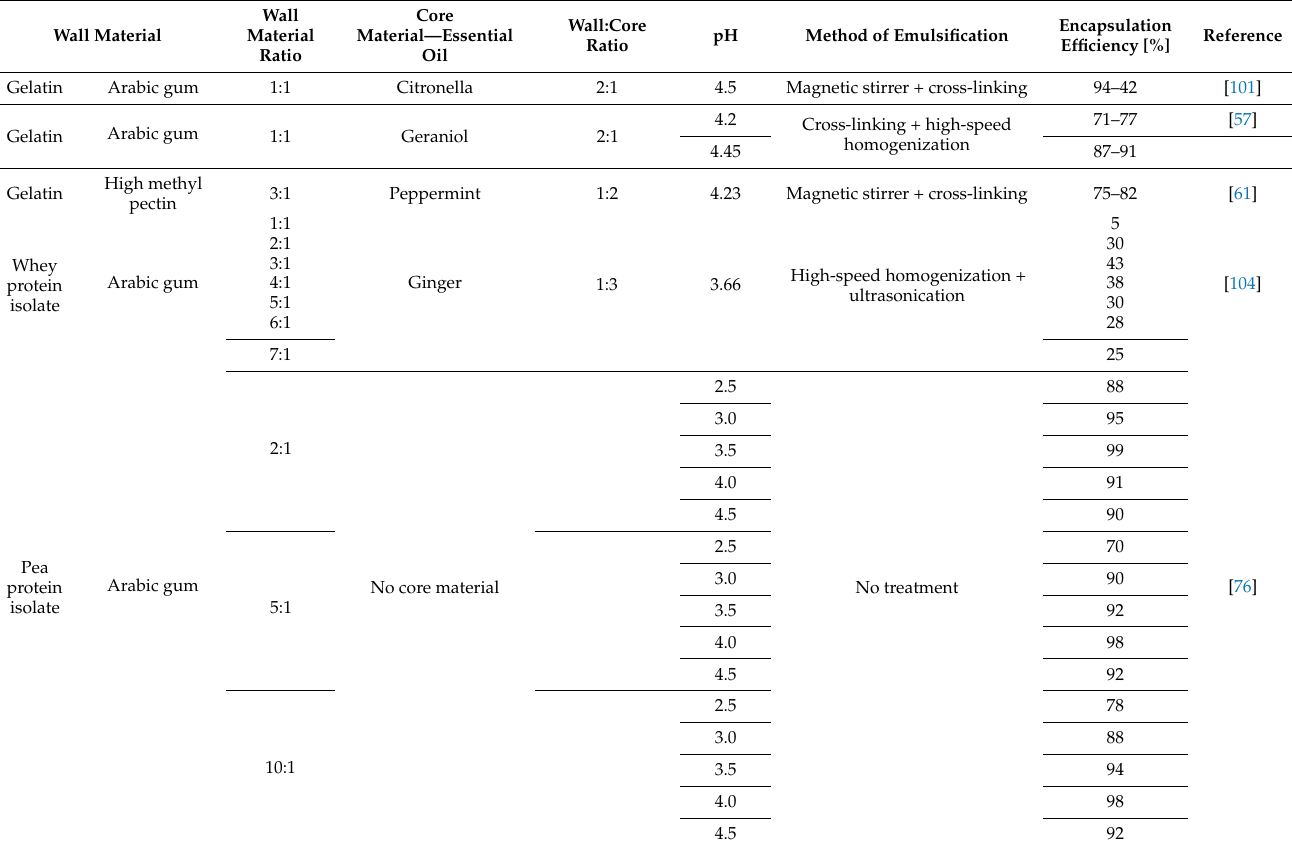
Table 1. Encapsulation efficiency depends on the wall materials used, and its own